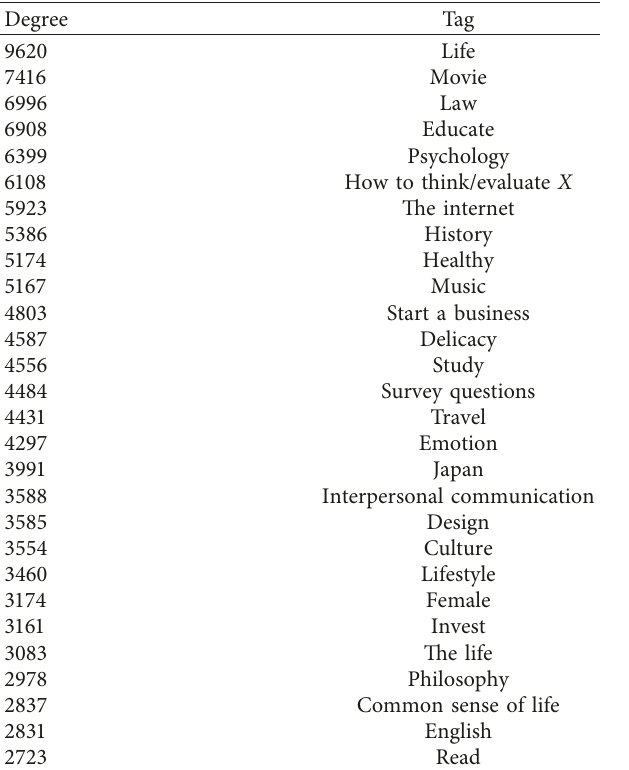
Figure 6: Degree distribution. Table 2: Tags with high